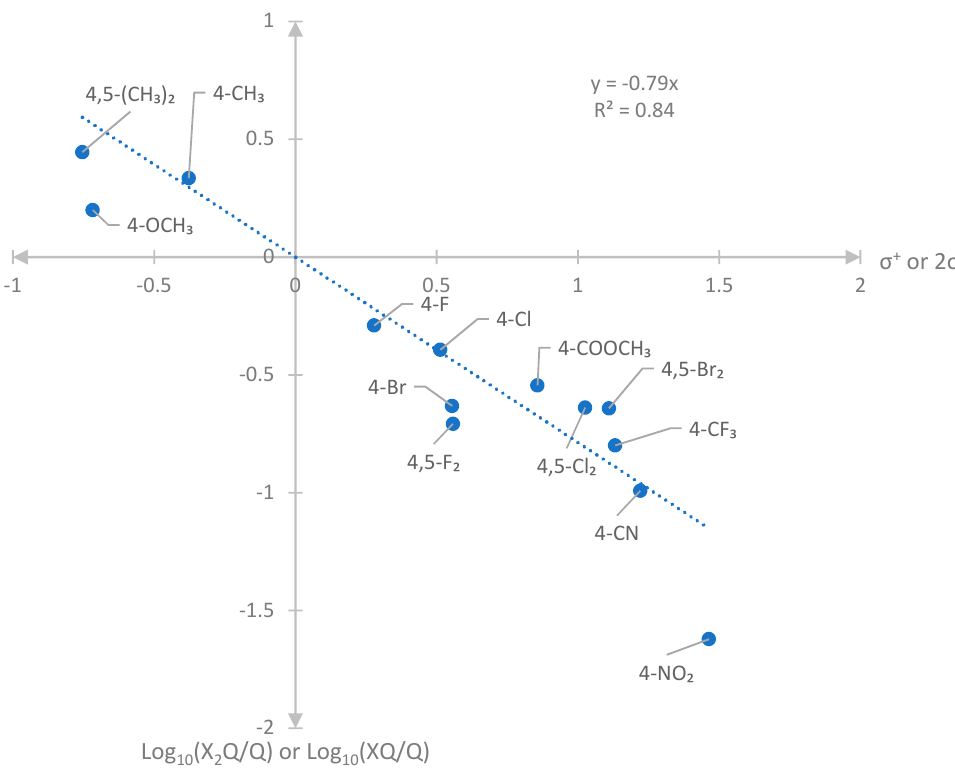
Figure 3. Hammett plot of XQ/Q ratio with standard composite σ constants and X 2 Q/Q ratio with doubled standard composite σ constants.